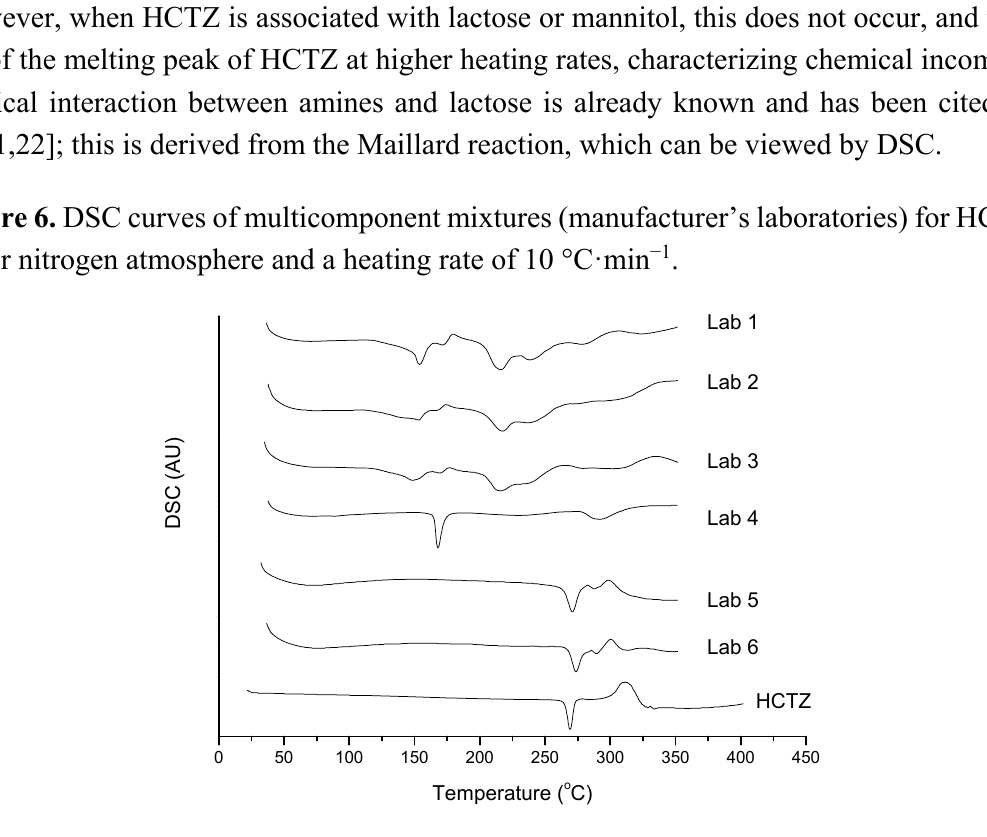
Figure 7. DSC curves of binary mixtures of HCTZ with each excipient (1:1),